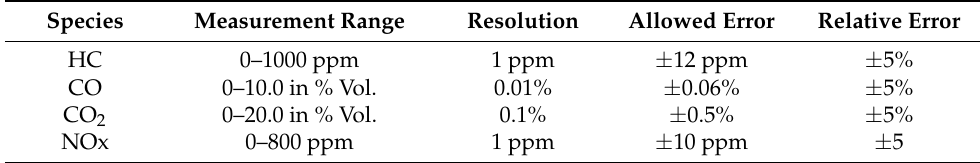
Table 7. Automobile Exhaust Gas Analyzer SV-50 measuring range.